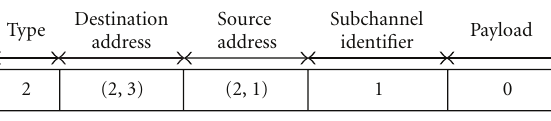
proposed hybrid router.